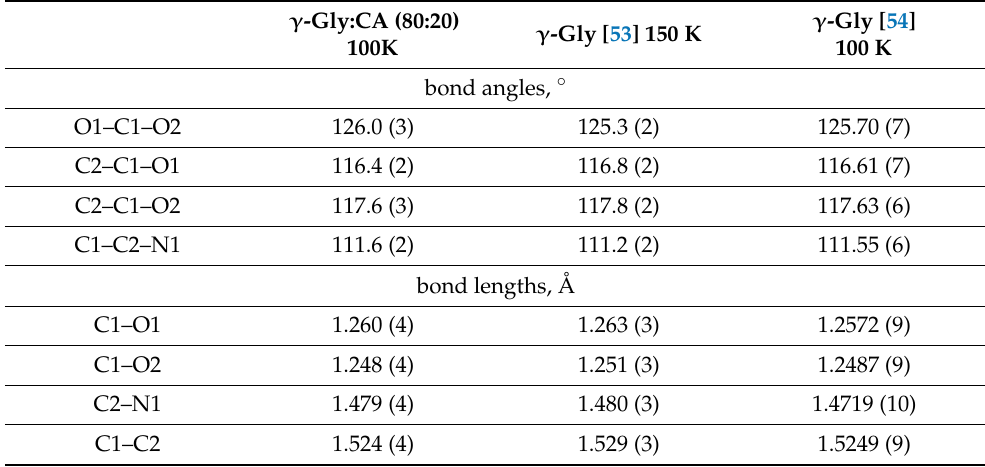
Table 5. Bond angles and bond lengths C1–O1, C1–O2, C2–N1, and C1–C2 of glycine molecule in CA-doped and nominally pure γ -Gly crystals